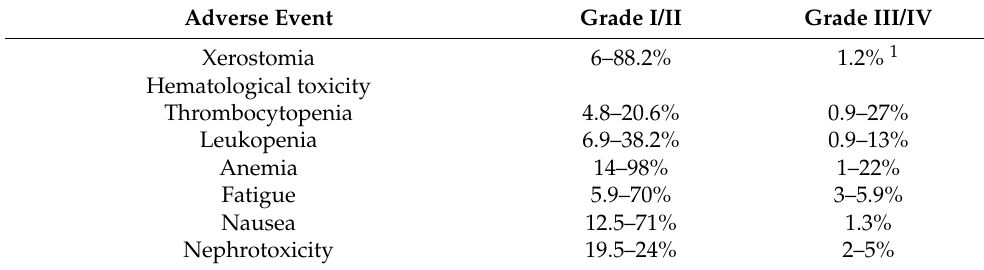
Table 2. Most common adverse events of PSMA-based radioligand